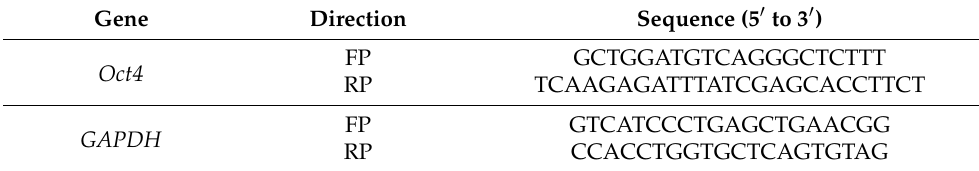
Table 3. Oligonucleotides used for